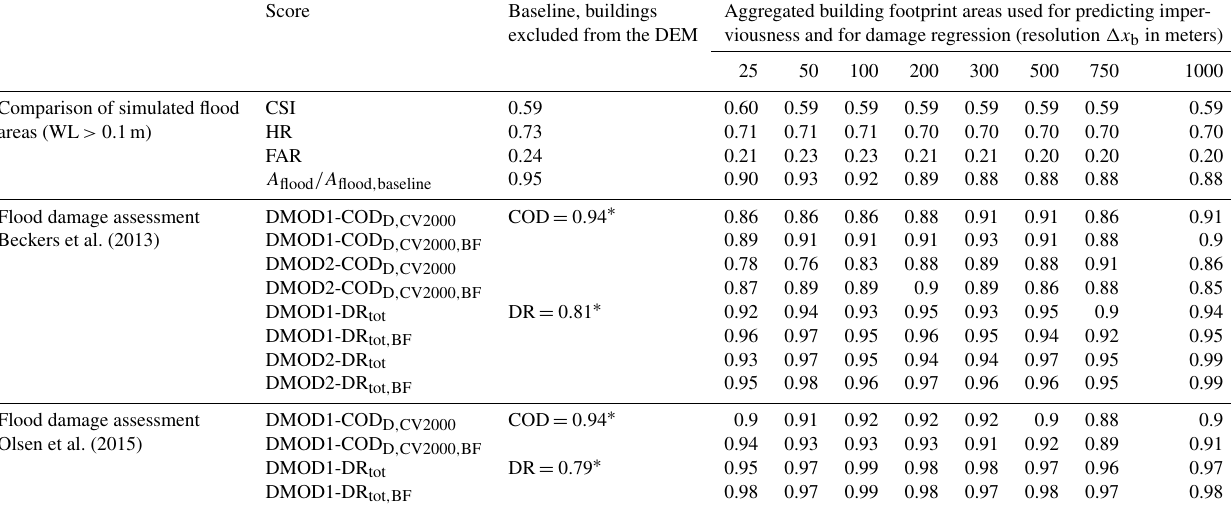
Table 3. Summary scores for return period T = 100 years. The top section compares flood areas simulated with the varying input datasets to the baseline simulation. The middle and lower sections evaluate goodness of fit for the damage regression models, considering separate results for the two damage assessment frameworks. Values shown for COD D and DR tot correspond to median values obtained during cross validation. The subscript BF marks those cases were flood areas from the baseline simulation were used to determine flooded building areas for regression. Score values for damage regression were derived at a fitting resolution (cid:49)x fit =